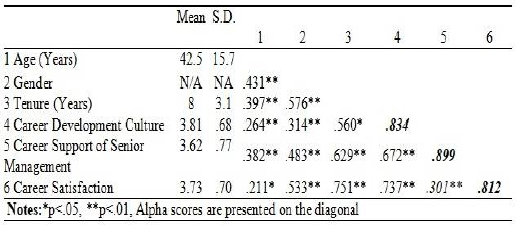
The results of Multiple Hierarchical